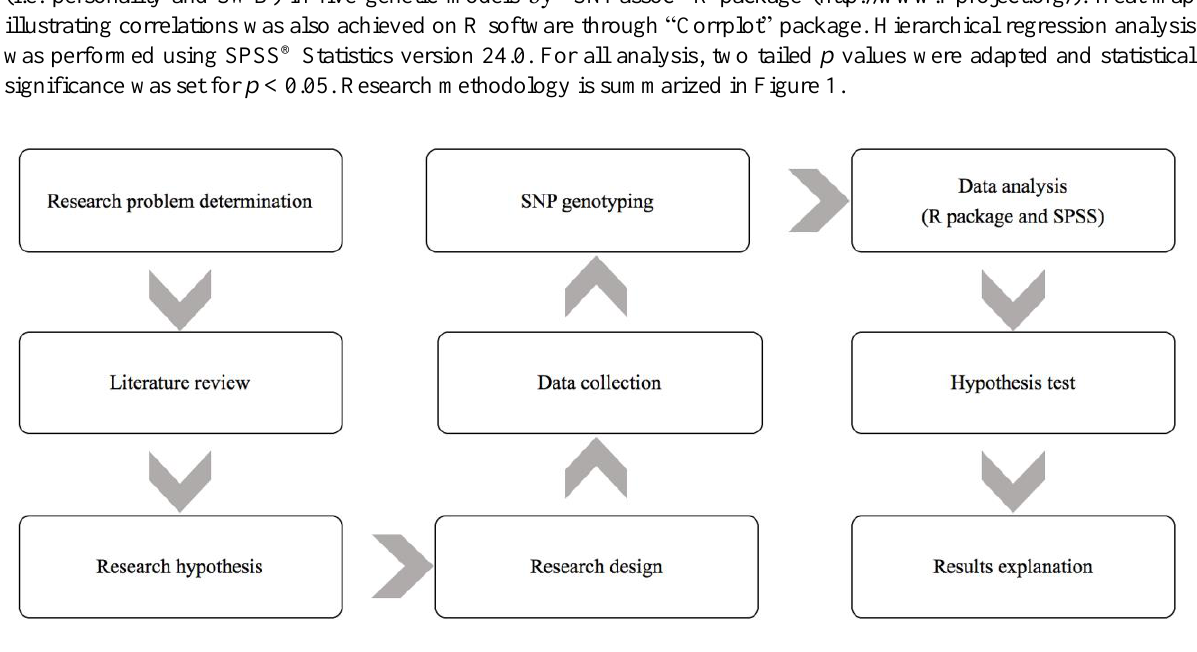
Figure 1. Research methodology